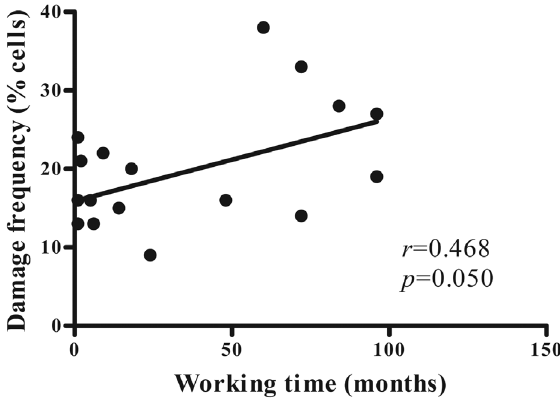
Figure 1 - Correlation between working time and damage frequency as evaluated by the Comet Assay; r and p : correlation coef fi cient and level of signi fi cance, respectively, according to Pearson’s